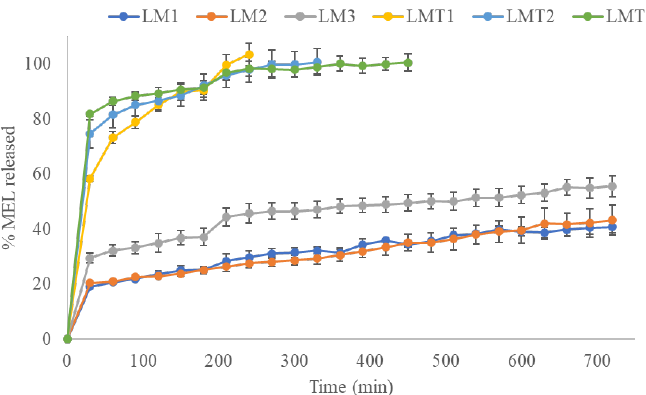
Figure 7. In vitro release profiles of MEL-loaded PLA nanofibers Melatonin-loaded PLA nanofibers with different concentration of drug 0.1% w/w (LM1), 0.3% w/w (LM2), 0.5% w/w (LM3), and Melatonin-loaded PLA nanofibers with Tween ® 80 and different concentration of drug 0.1% w/w (LMT1), 0.3% w/w (LMT2), 0.5% w/w (LMT3) in phosphate buffered solution (pH 7.4) at 37 °C. Each point represents the mean value of three different experiments ± S.D.